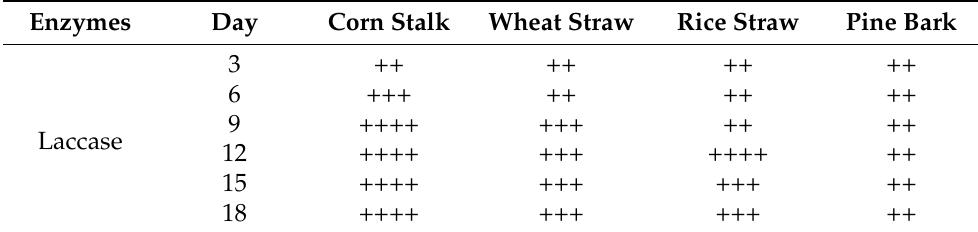
Table 2. Enzyme performance in SSF